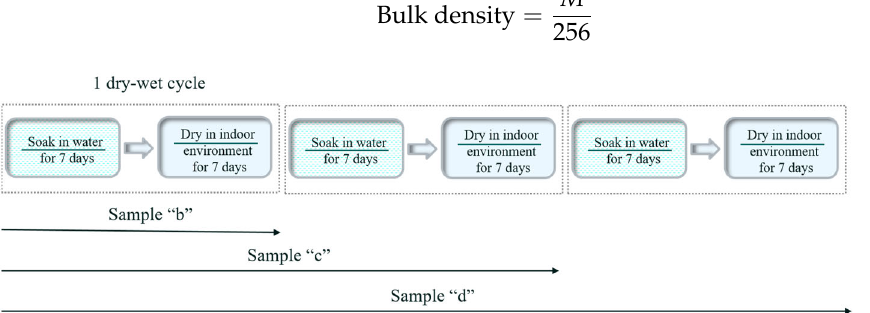
Figure 2. Schematic diagram of dry–wet cyclic experiments for the MOC samples and their corresponding sample labels.